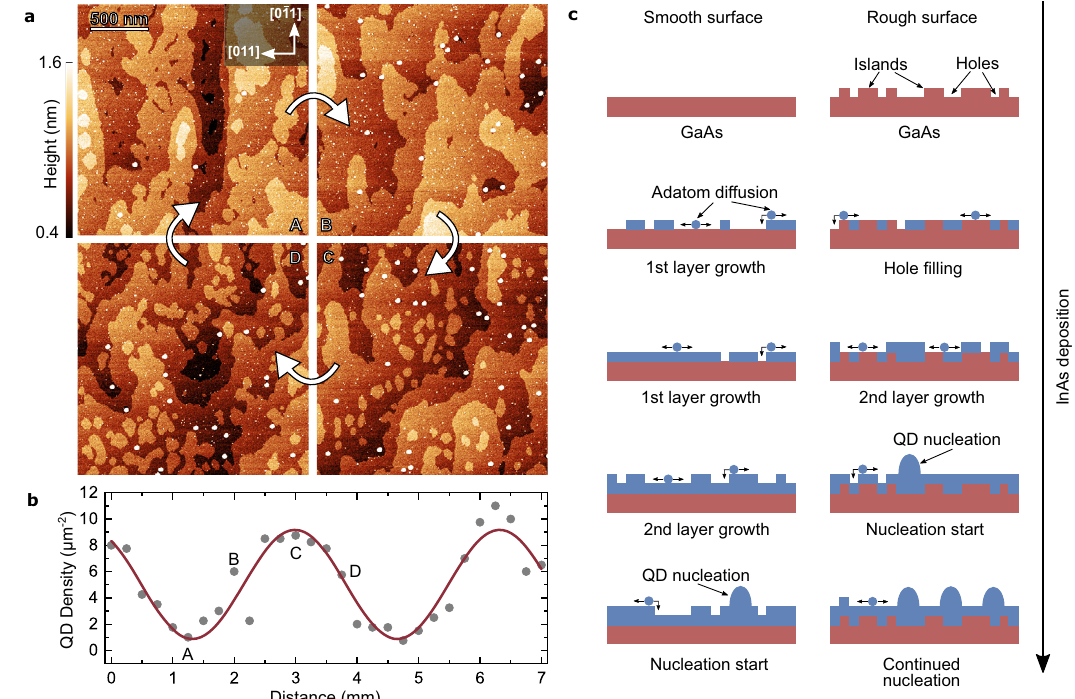
Fig. 3 Atomic force microscopy measurements of surface QDs and enhanced nucleation schematic. a AFM images of surface QDs along the PDL GaAs gradient direction. b QD densities determined from AFM images along the PDL direction (gray dots) and sinusoidal fi t (red line). The images in ( a ) are marked by the corresponding letters and represent one PDL, i.e. GaAs ML cycle. c Schematic illustrating InAs layer (blue) development under increasing InAs deposition on a smooth and rough GaAs surface (red). Adatom diffusion (blue dots) takes place on the surface. QD nucleation (blue domes) on rough surfaces starts earlier than on smooth